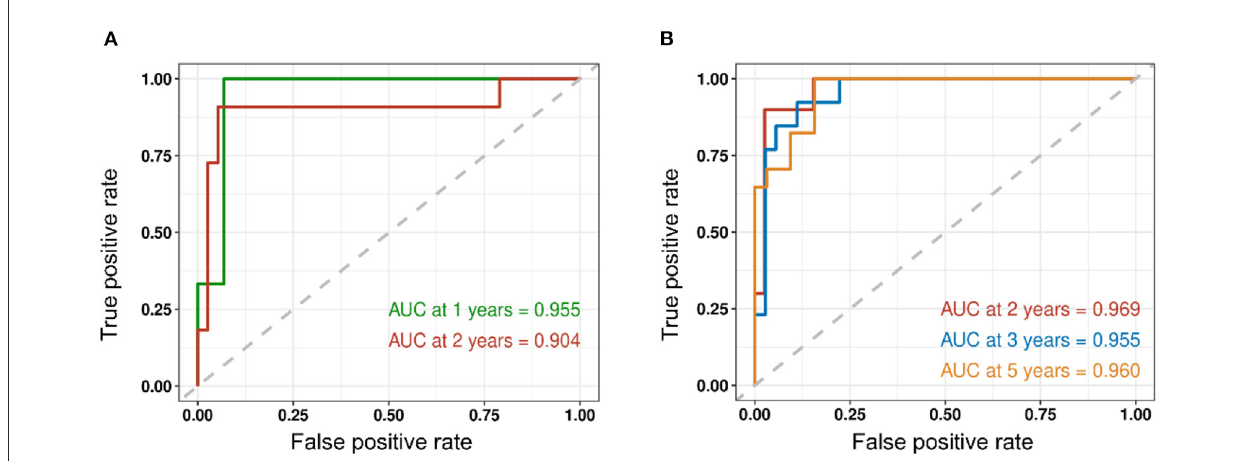
FIGURE2 Time-dependent receiver operator characteristics (ROC) analysis of recurrence and survival is shown. (A) The 1- and 2-year DFS were 0.955 and 0.904, respectively. (B) The 2-, 3-, and 5-year OS were 0.969, 0.955, and 0.960, respectively.